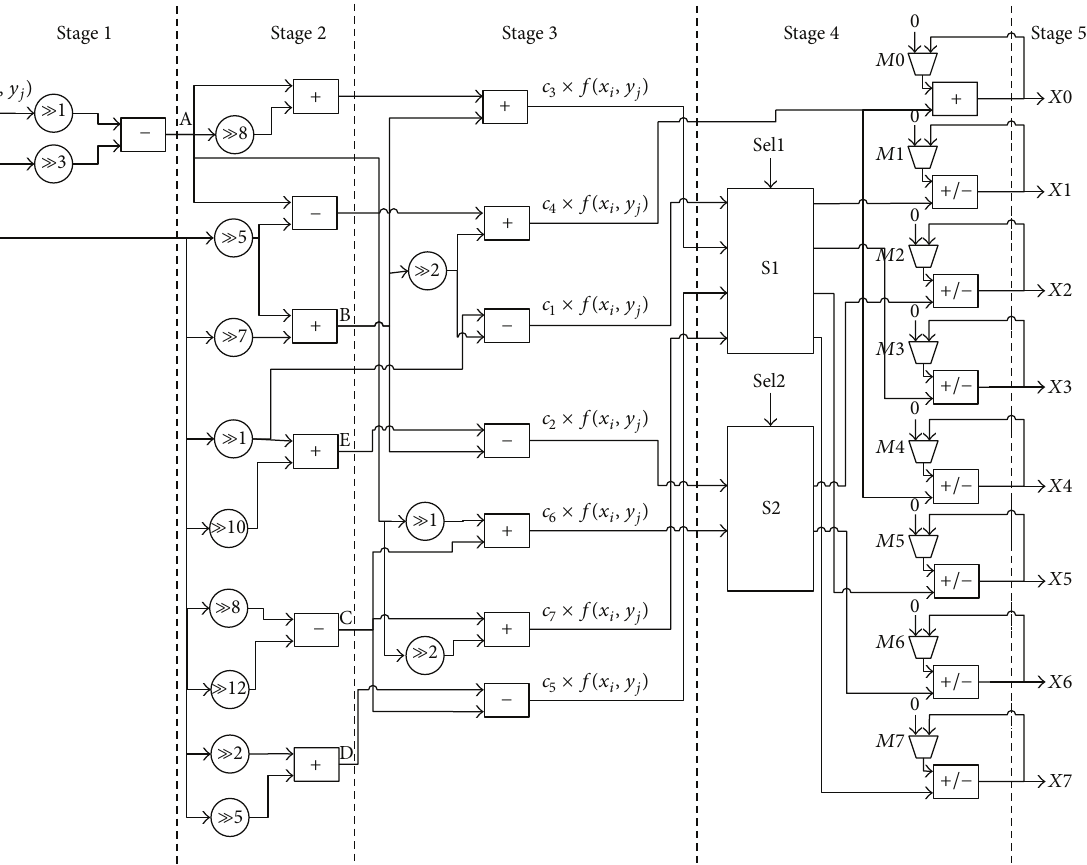
Figure 2: Proposed 5-stage pipelined DCT architecture.